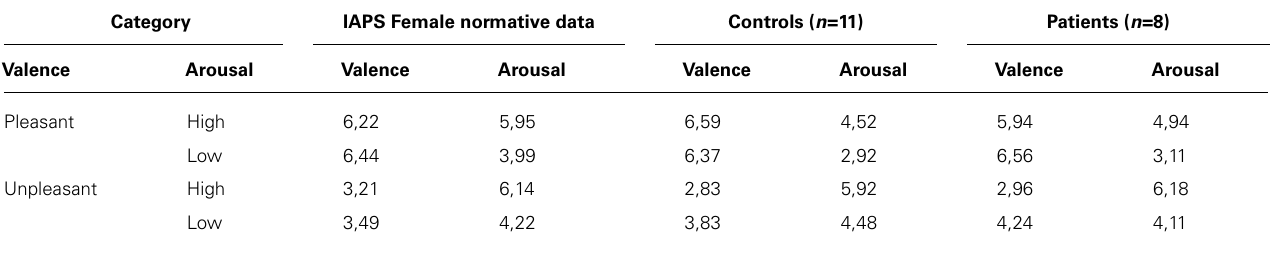
Table 4 | Comparison of the mean arousal and valence ratings between the InternationalAffective Picture System FEMALE norms (from the Center for the Study of Emotion andAttention, Lang etal., 2008) and the current study subjective evaluations for the controls and our patients.